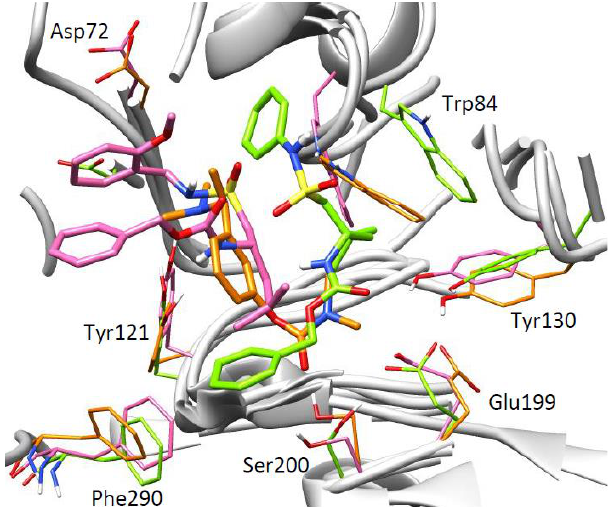
Figure 5. Spatial view of AChE- 5d (green), AChE- 5k (pink), and AChE-RIV (orange) complexes overimposed for comparison.